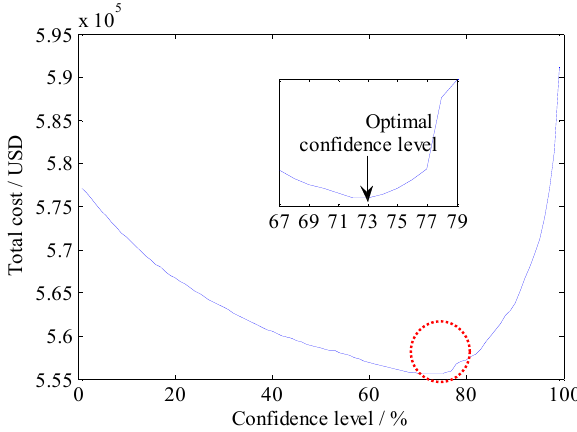
Figure 7. Total cost under different confidence levels for 10-units system (Case 1). Table 2. The costs for Case 1 and Case 2.